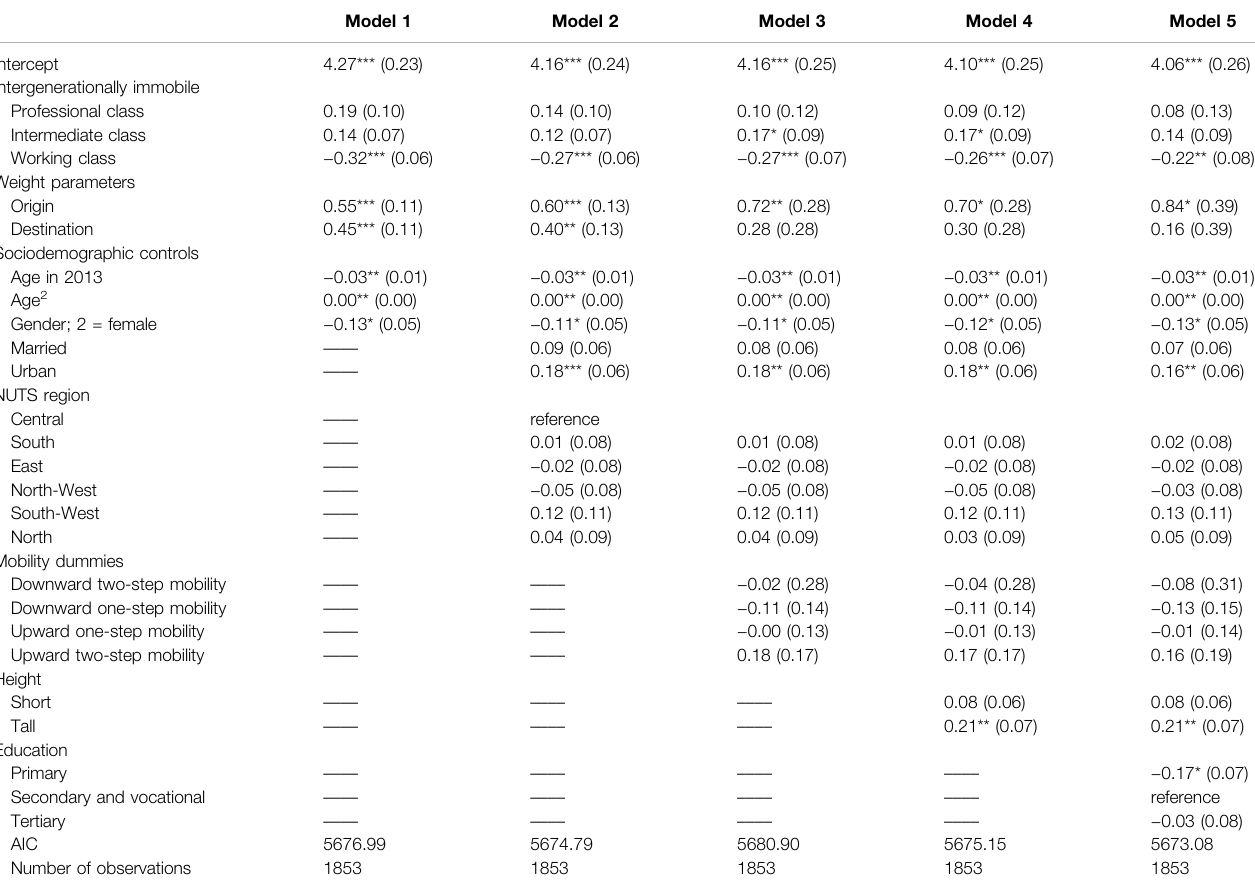
TABLE 2 | Base and full models for self-rated